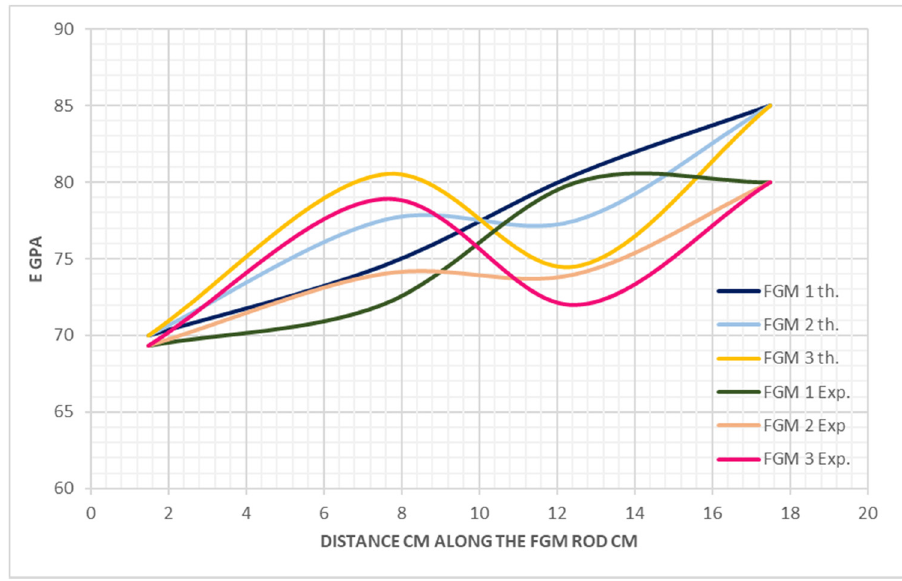
Figure 12: Elastic modulus via distance along the FGM rod.